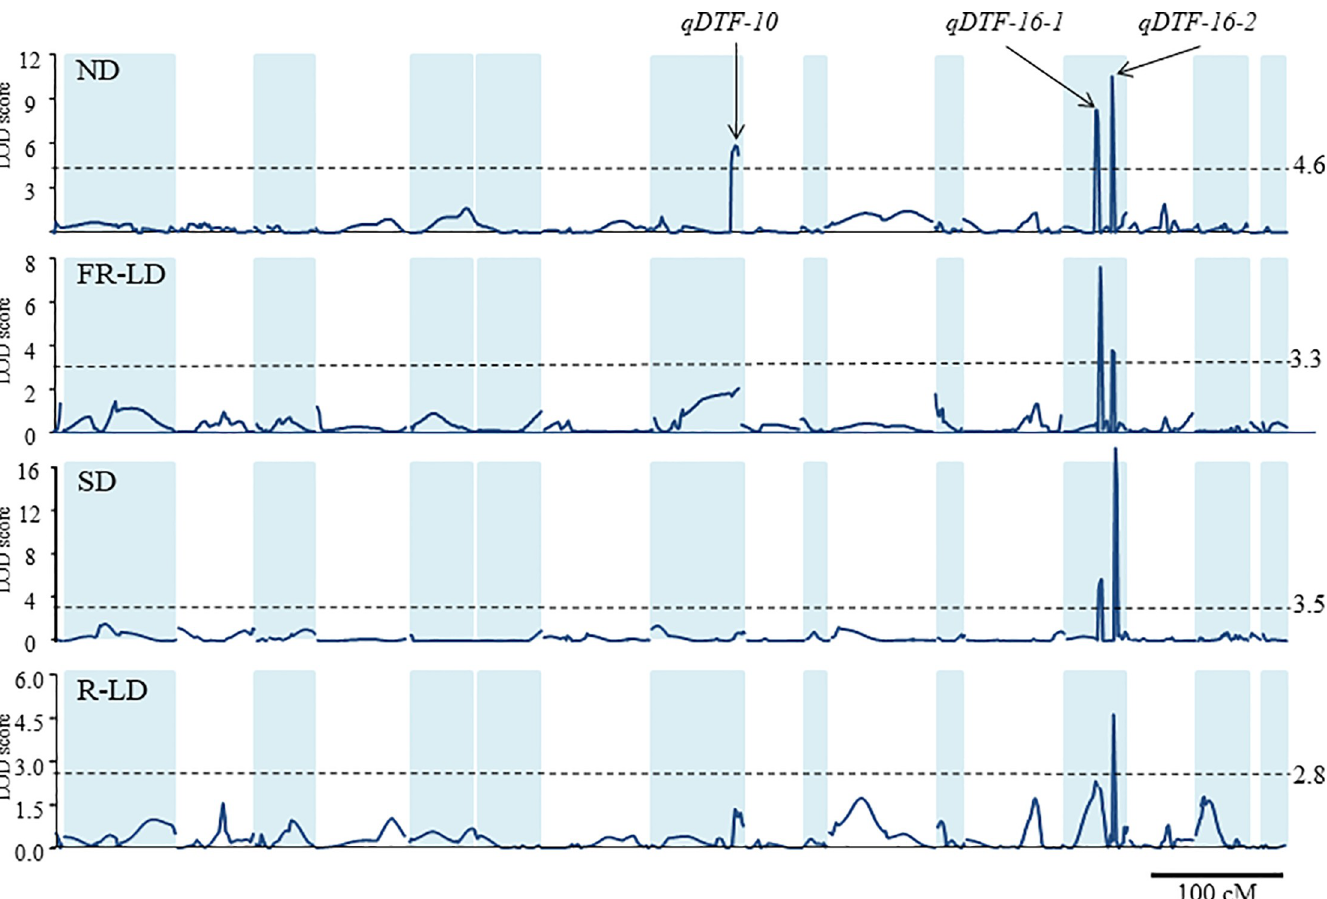
Fig 4. LOD scores for QTLs controlling the flowering time under four photo-thermal conditions in the F 6 progeny of the cross between soybean lines AGS292 and AK16. Dotted lines indicate significant LOD scores at the 5% level by the 1,000 permutation test.